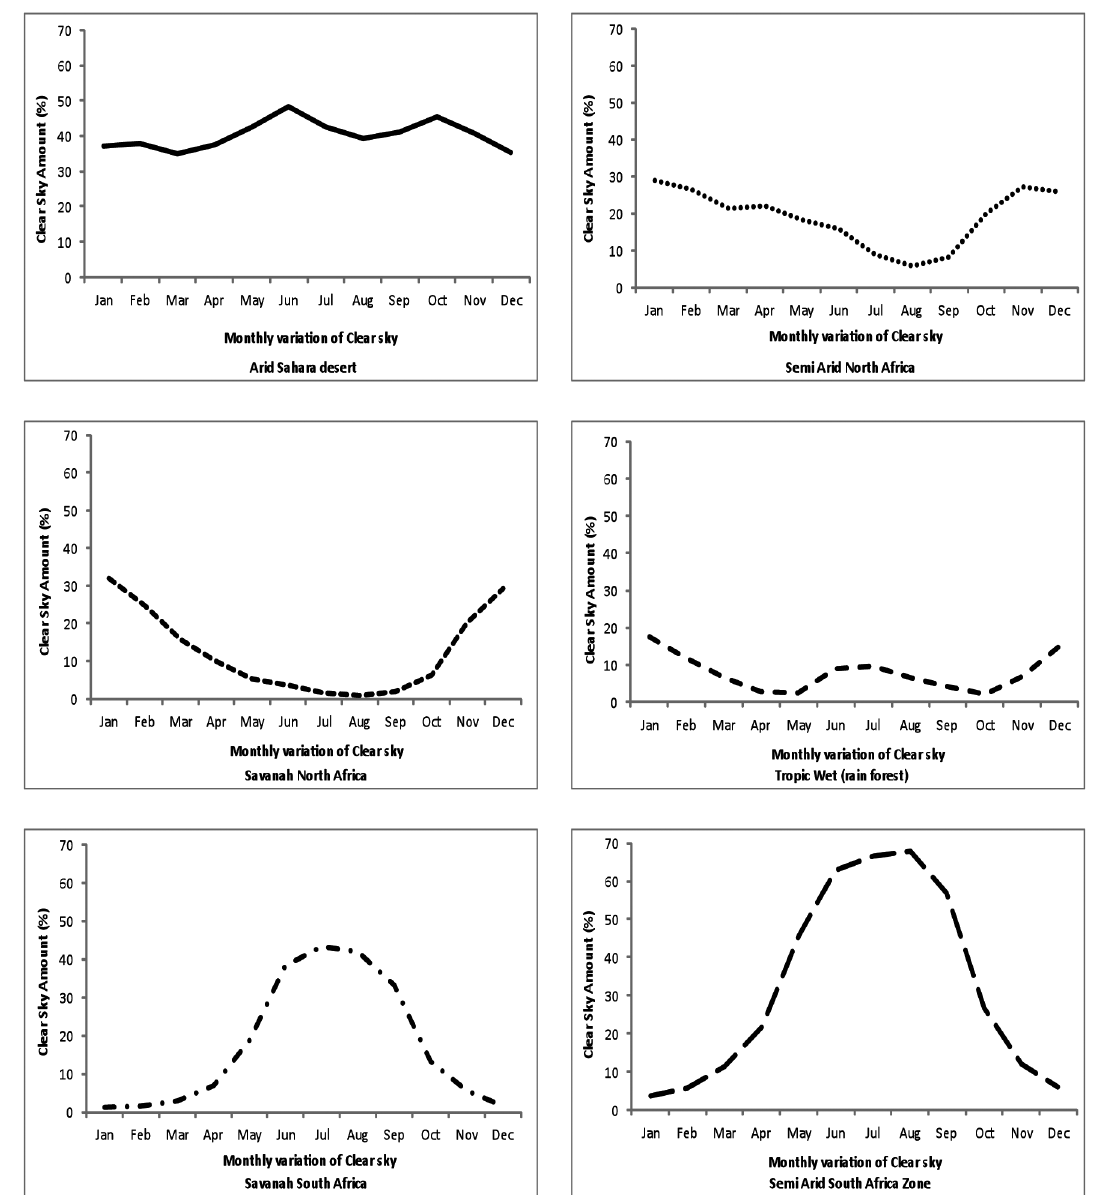
Figure 5. Monthly clear sky distribution in the six major climatic